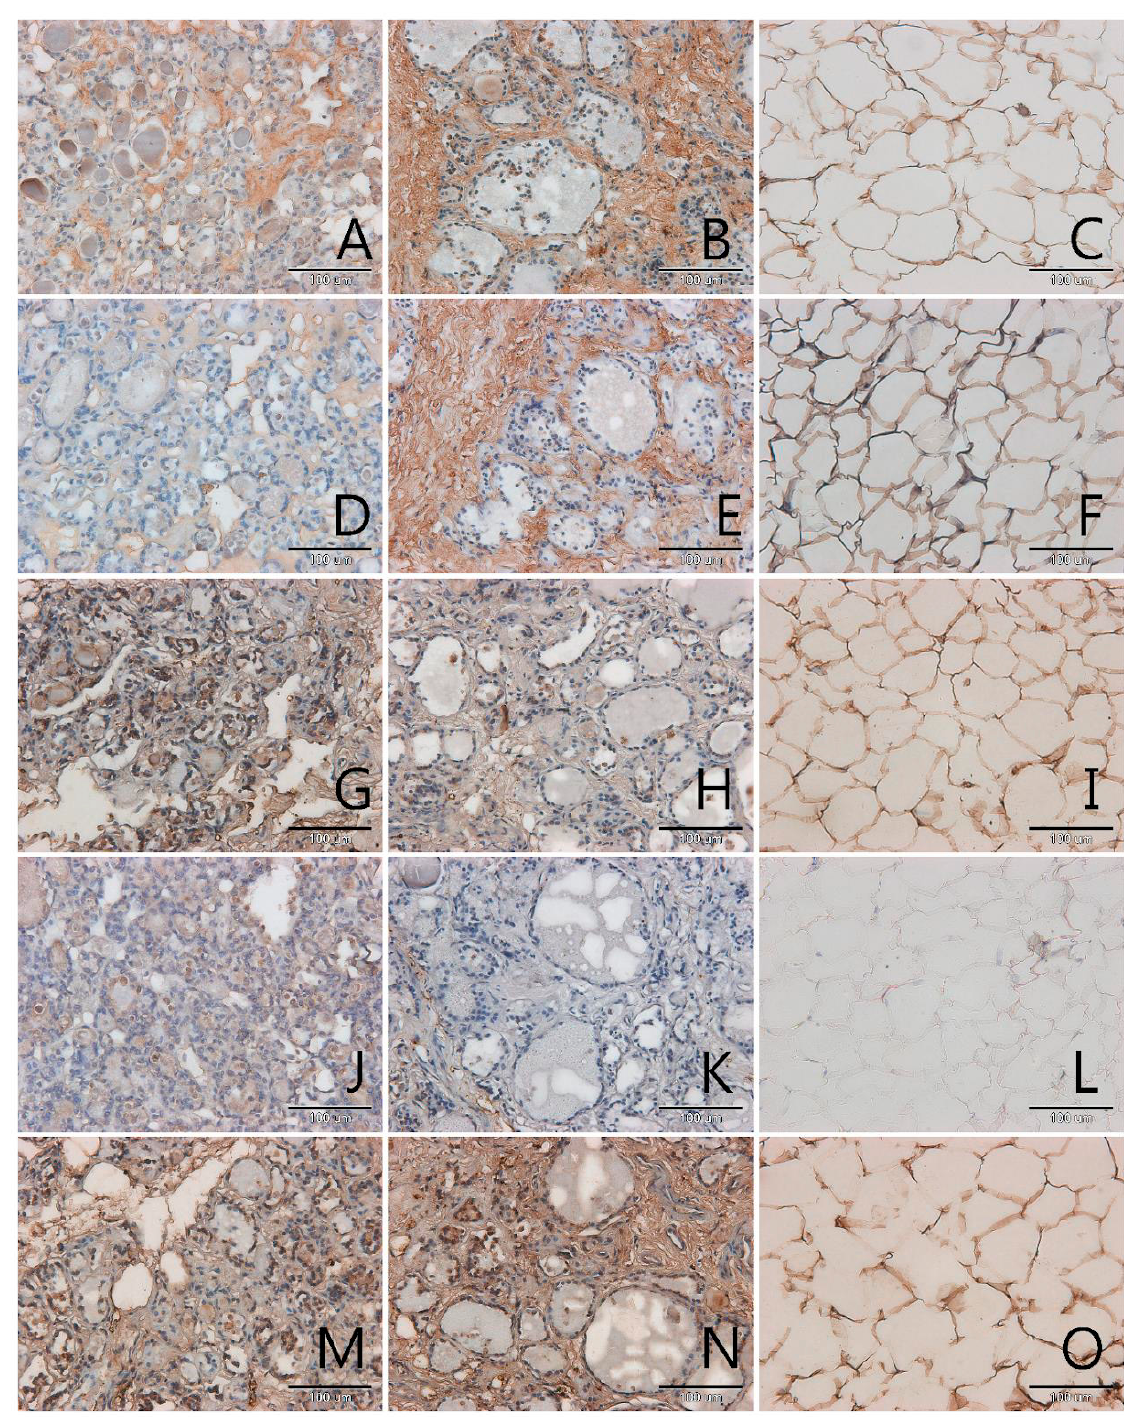
Figure 4. Immunohistochemical detection of AGEs ( A – C ), RAGE ( D – F ), SR-A ( G – I ), SR-BI ( J – L ) and NOS-3 ( M – O ) in sections of the thyroid gland with follicular adenomas ( A , D , G , J , M ), in the paired control sections ( B , E , H , K , N ) and in the fatty tissue surrounding the tumor ( C , F , I , L , O ). Magnification 200× (scale bar 100 µm).